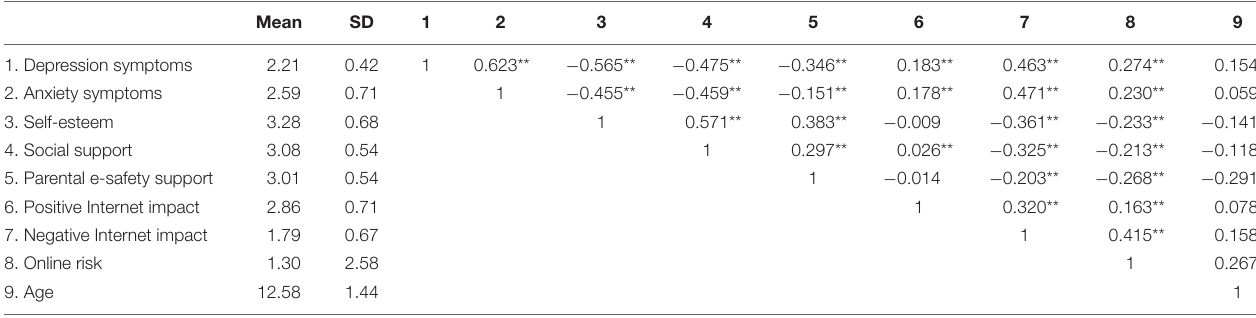
TABLE 1 | Descriptive statistics and Pearson’s r correlations between psychological distress and internet related measures. Mean